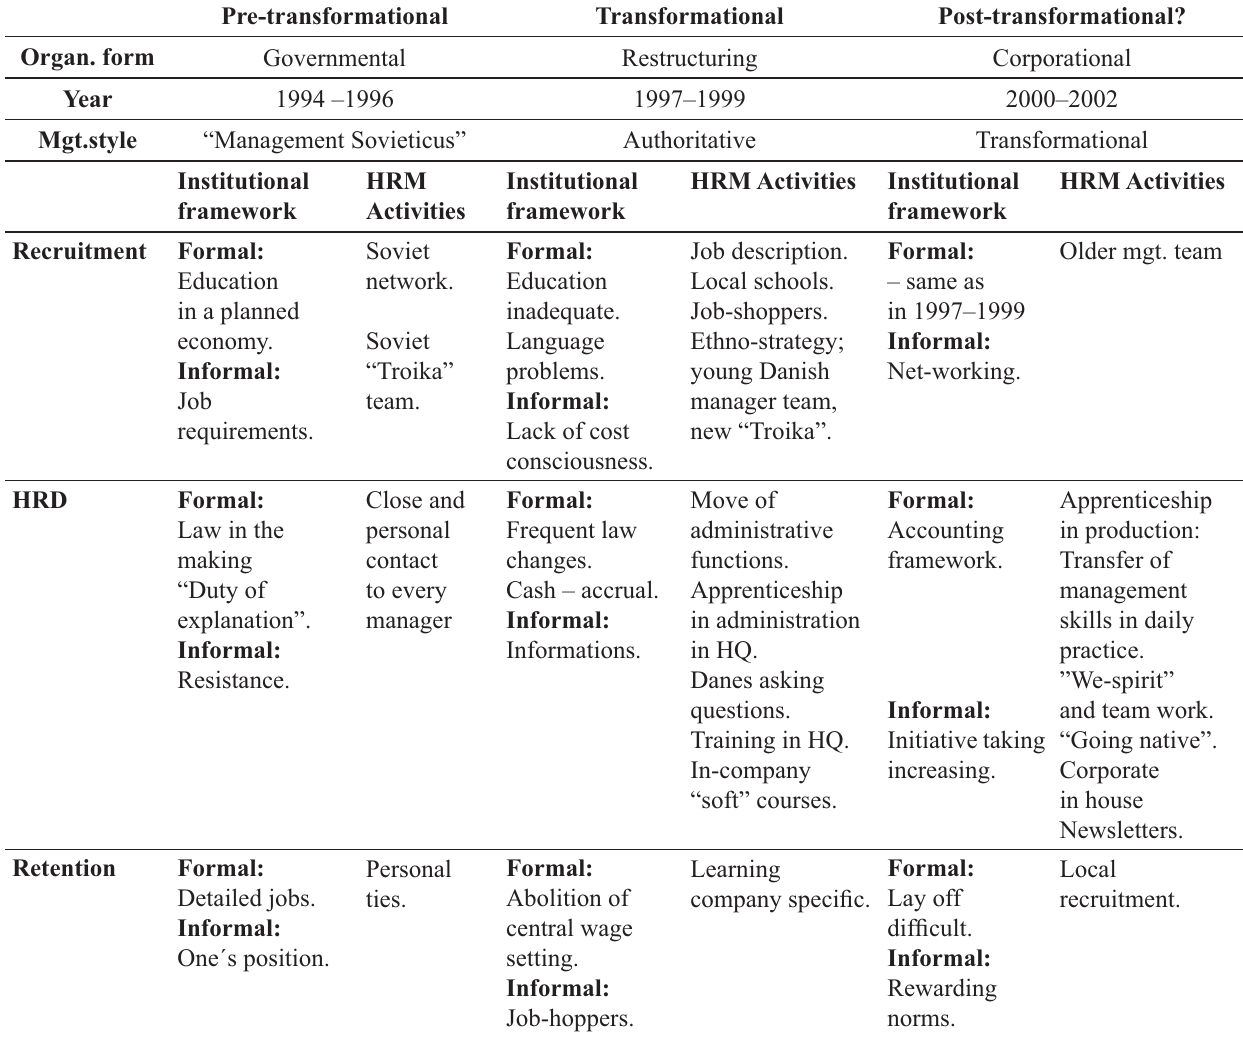
Table 1. Important changes in the institutional framework and localization of